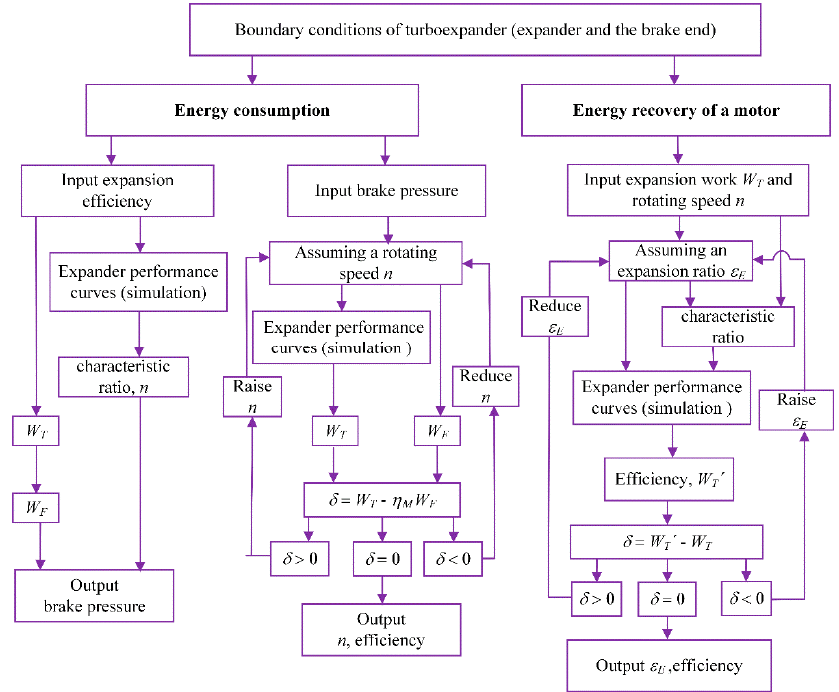
Figure 4. The unified matching model of turboexpander.